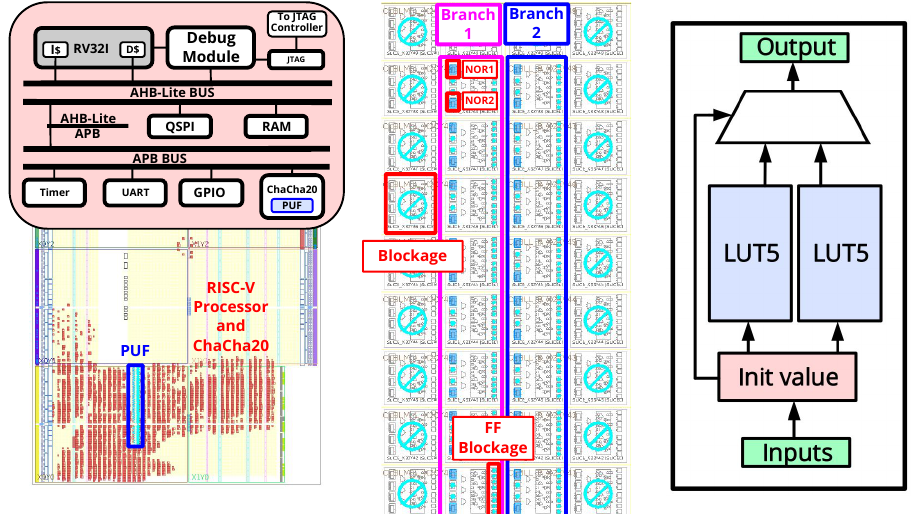
Figure 8. Strategies and constraints in the PUF implementation.